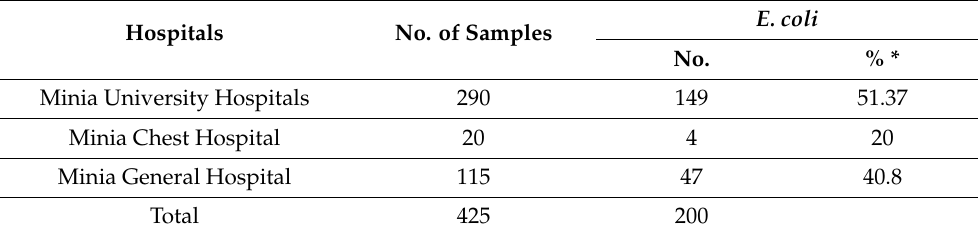
Table 2. Distribution of E. coli among samples collected from different hospitals.